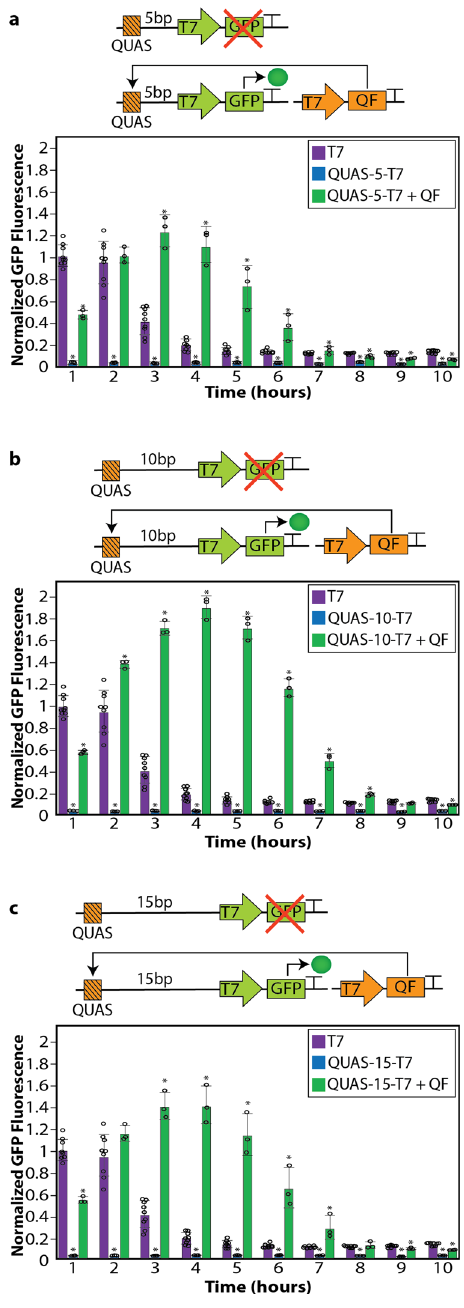
upstream of the T7 promoter (Fig. 2 and Supplemental Table 2).